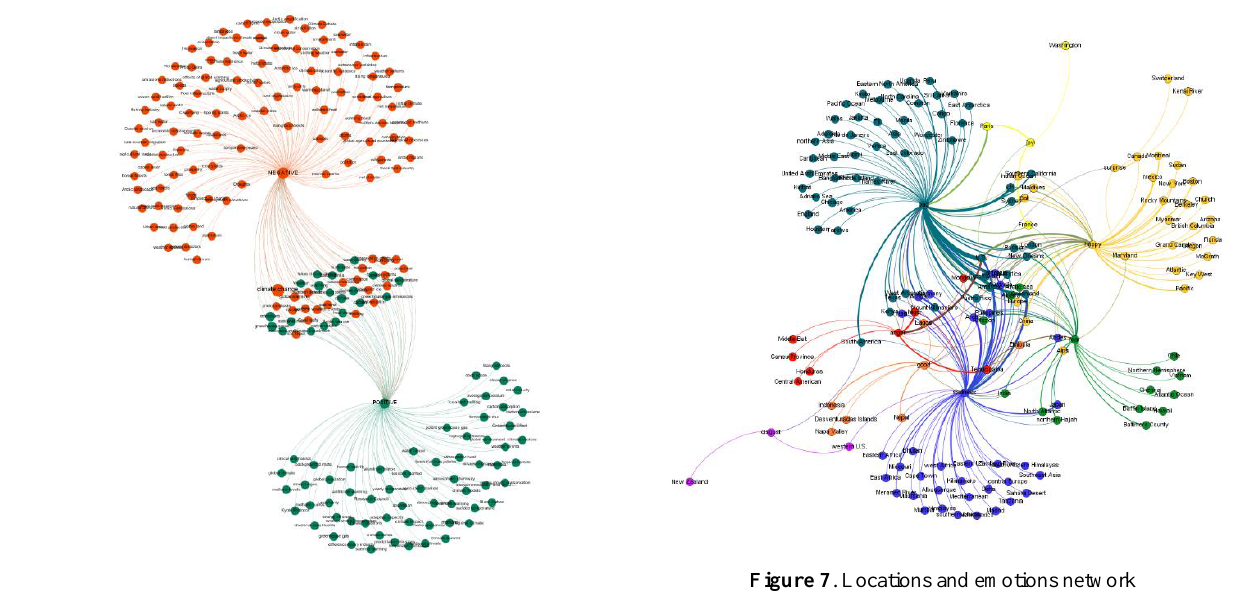
Figure 4 . Environmental terms polarity network